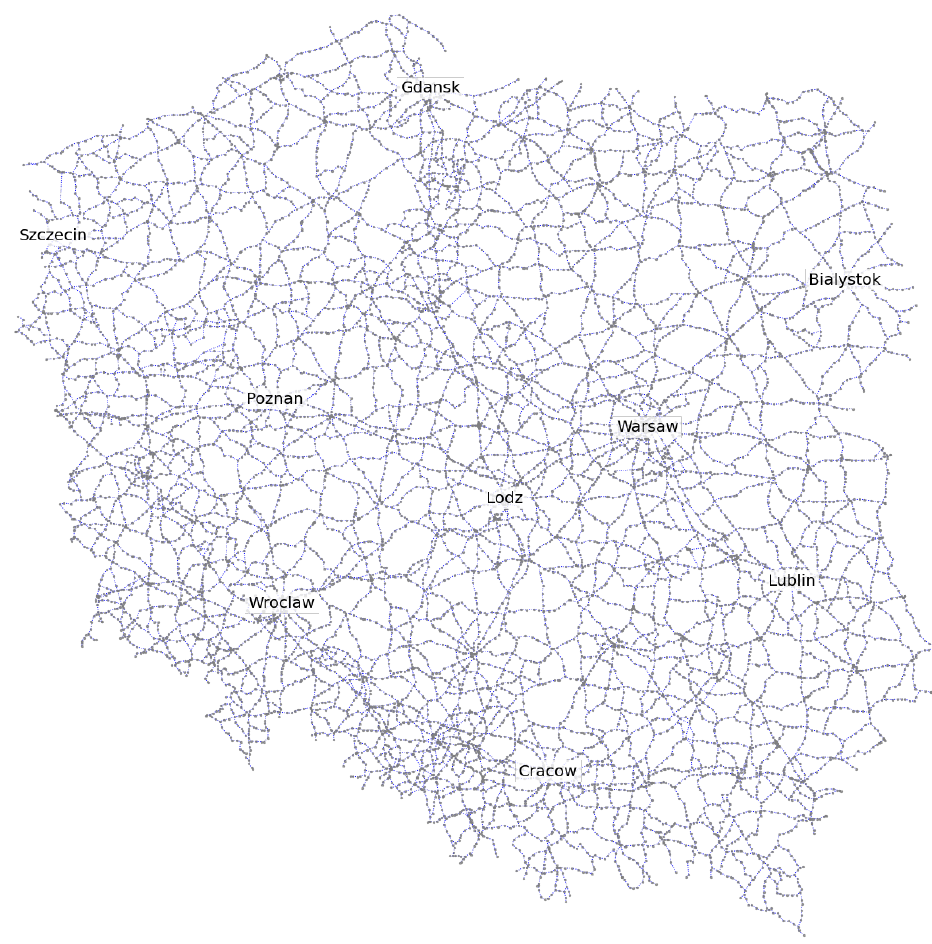
Figure 1. Representation of the road network model of Poland created with the developed software.